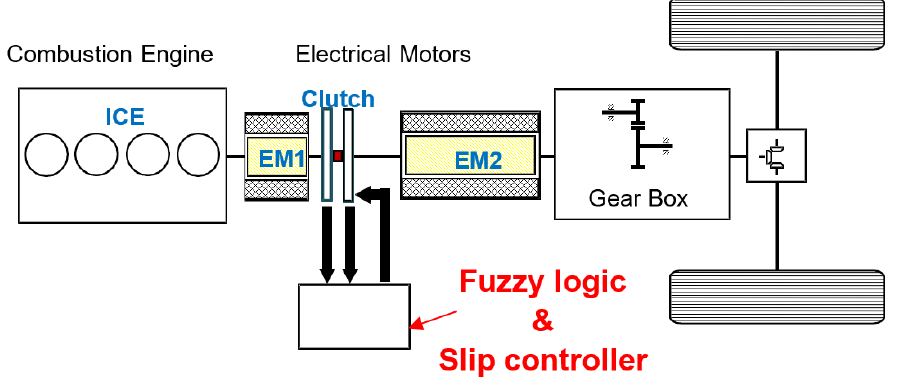
Figure 2. Fuzzy logic and slip controller.